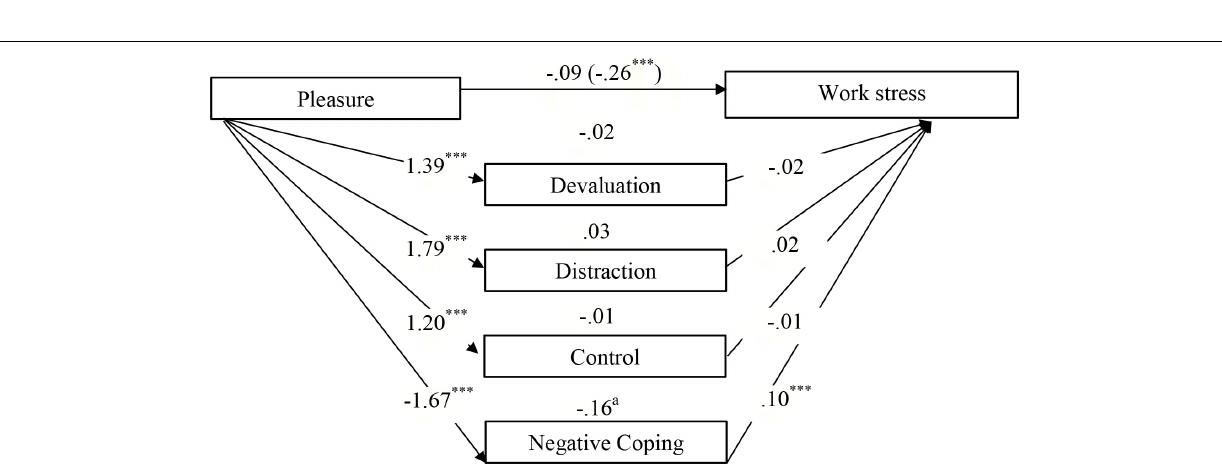
FIGURE 5 | Direct, indirect, and total effects (in brackets) of Pleasure on Work Stress via the mediators Positive (Devaluation, Distraction, Control) and Negative Coping Strategies (Controlled for age and gender). ∗∗∗ p < 0.001. a Significant point estimates ( p < 0.05).